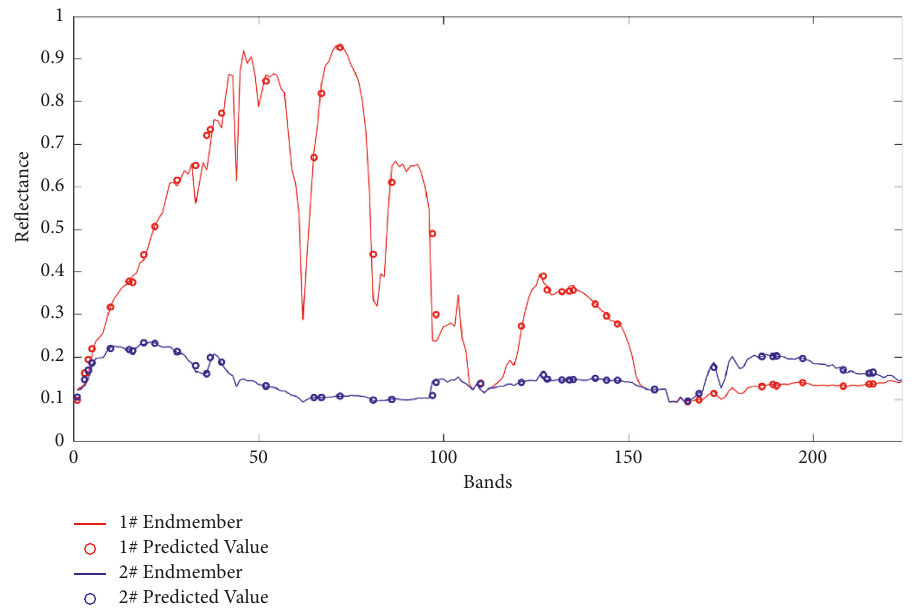
Figure 2: Endmember predicted for key bands.